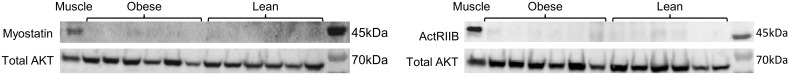
Protein expression of Myostatin precursor and ActRIIB proteins in crest fat of lean and obese horses and ponies.Protein expression of myostatin precursor protein and ActRIIB was assessed by Western blot with total AKT used as a loading control. Blots are shown for crest fat expression across all animals with a skeletal muscle sample used as positive control. n = 6/group.